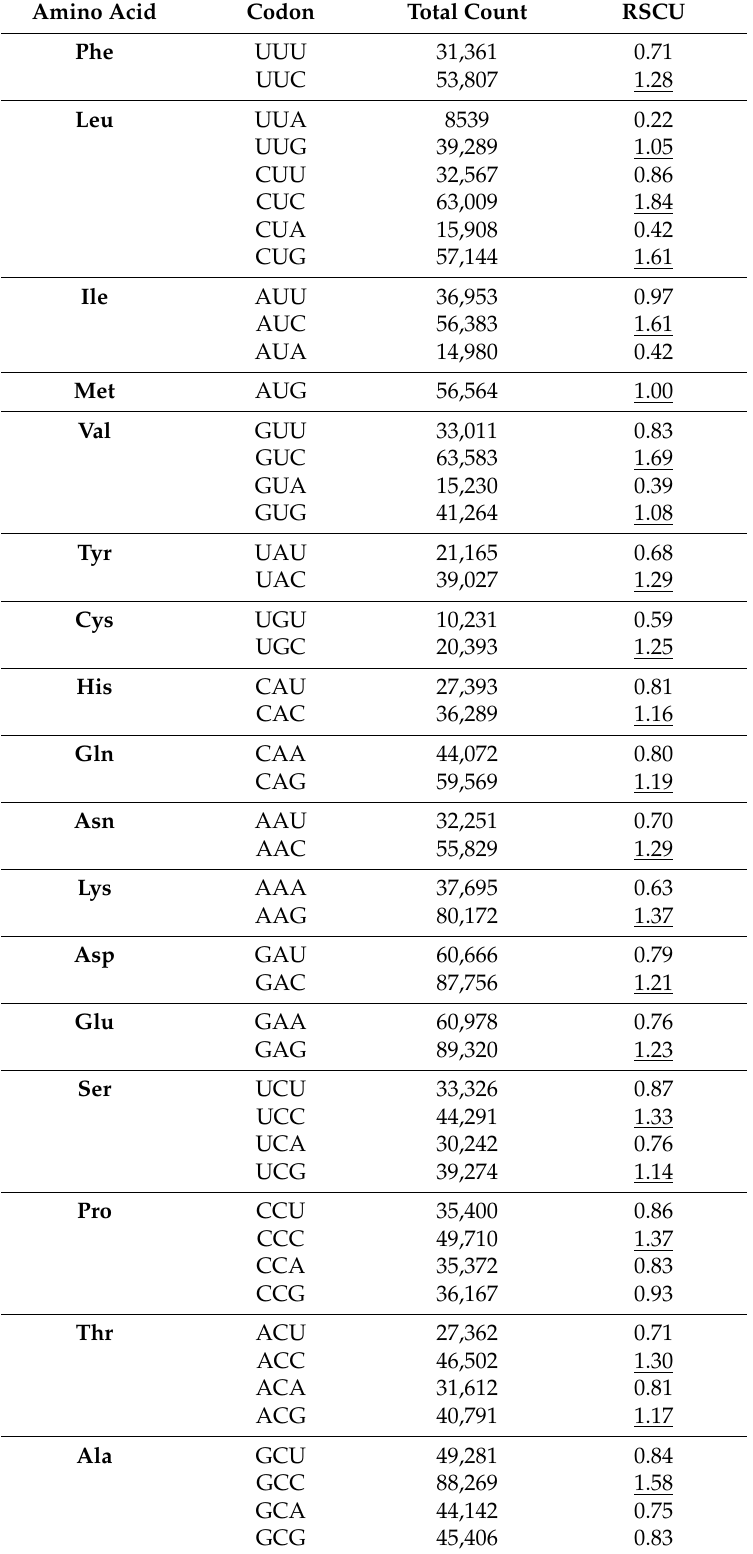
Table 4. Codon usage of Epichloë